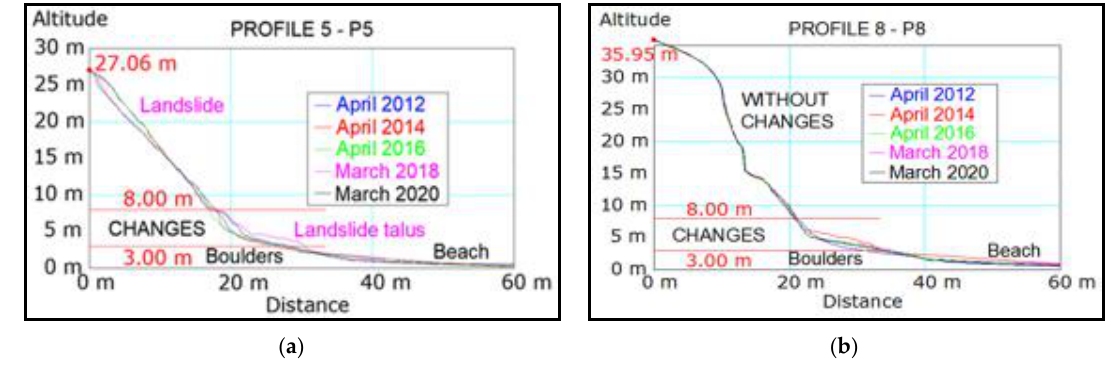
Figure 8. Cliff profile evolution between the more significant campaigns. ( a ) Profile 5 shows a landslide that occurred in March 2018; ( b ) Profile 8 contains a rocky substrate.